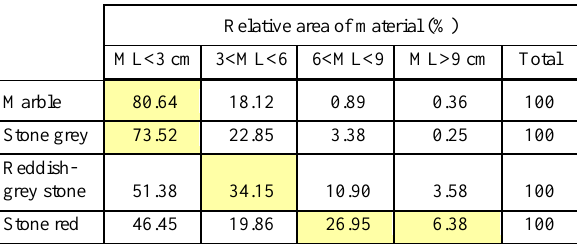
Table 3. Normalization of table 2 values according to the share of each building material on the examined wall surface.